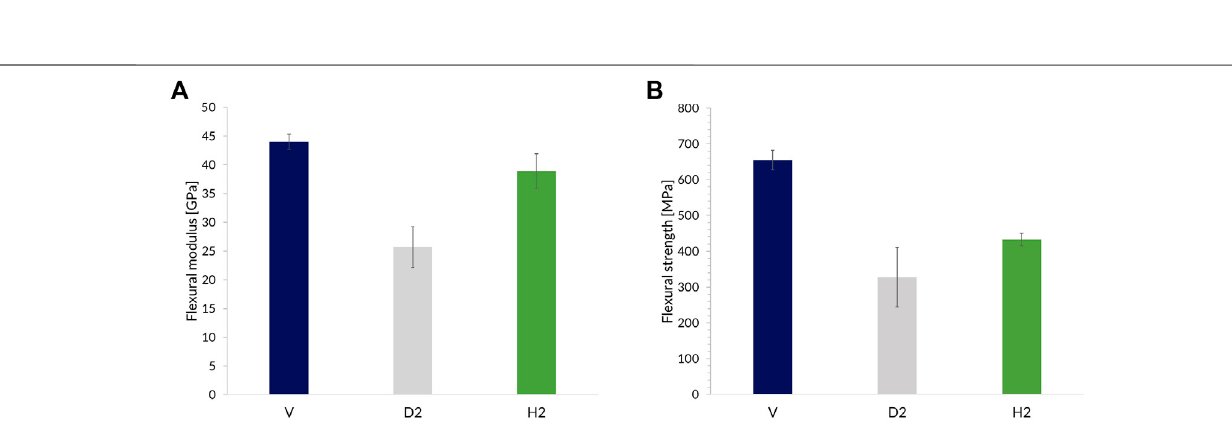
FIGURE 6 | (A) The fl exural modulus and (B) the fl exural strength for V, D2, and H2 [(0/90)] 18 specimens.